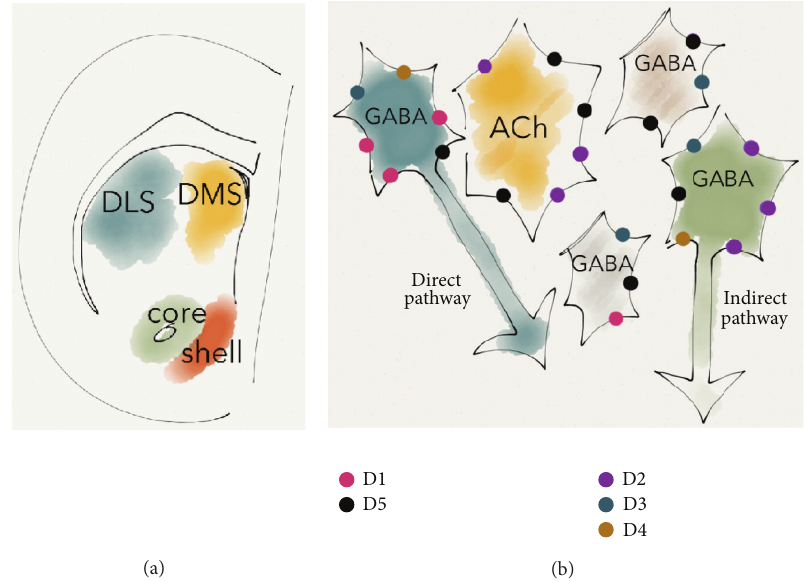
Figure1:Dopaminereceptorexpressiononstriatalneurons.(a)Schematicdrawingshowingstriatalsubregionsinarodentcoronalbrainslice. (b) Dopaminergic receptors are highly expressed on striatal GABAergic (GABA) and cholinergic (ACh) neurons in a pathway and subtype specific